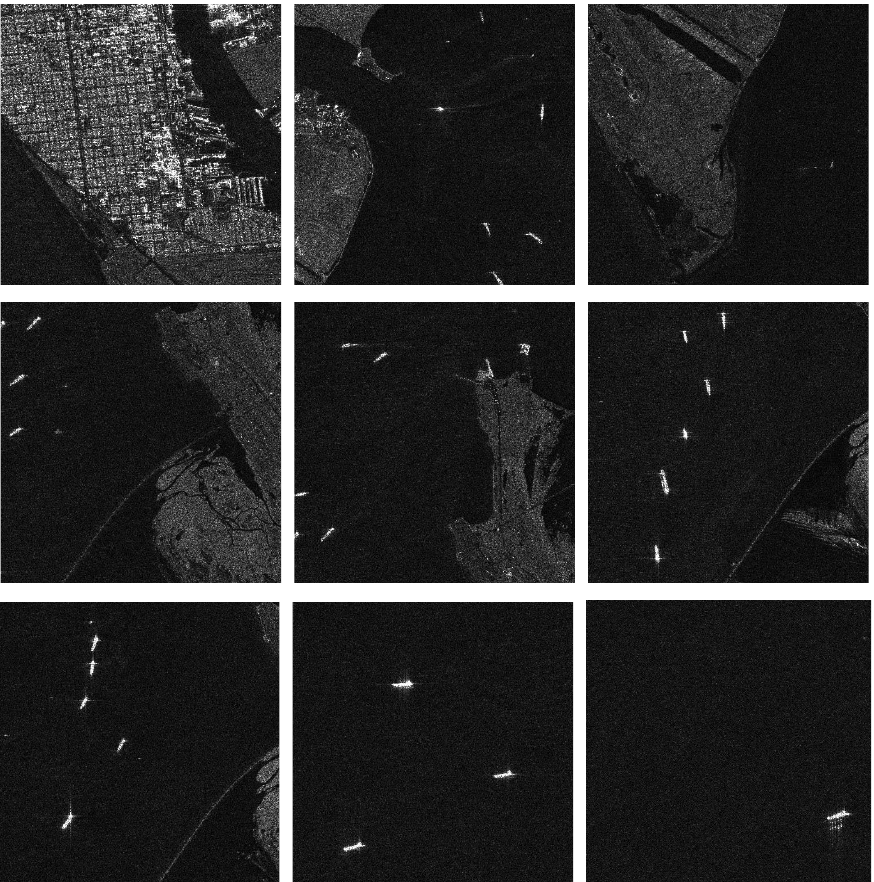
Figure 10. The ship target images in the HRSID dataset.